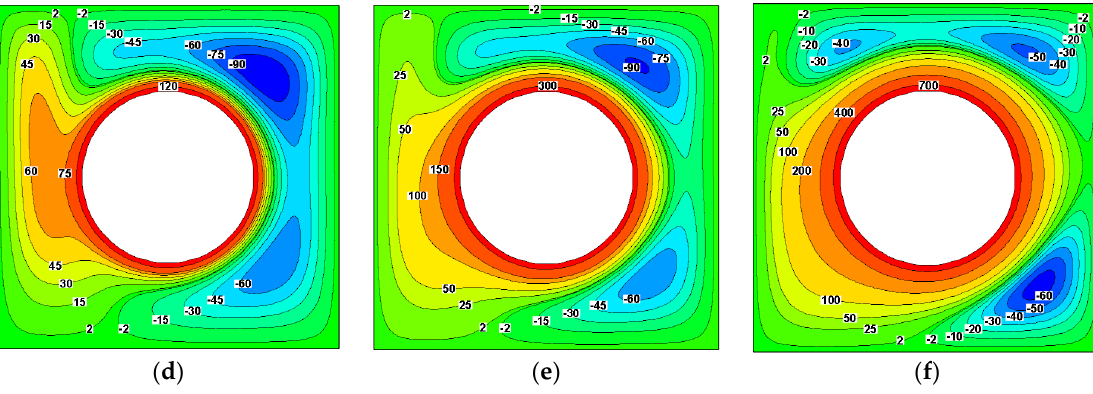
Figure 6. ( a ) N = 0, ( b ) N = 10, ( c ) N = 20, ( d ) N = 50, ( e ) N = 100, ( f ) N = 200. Contours of stream function at λ = 0.5, Ha = 40 and Ra = 10 6 .